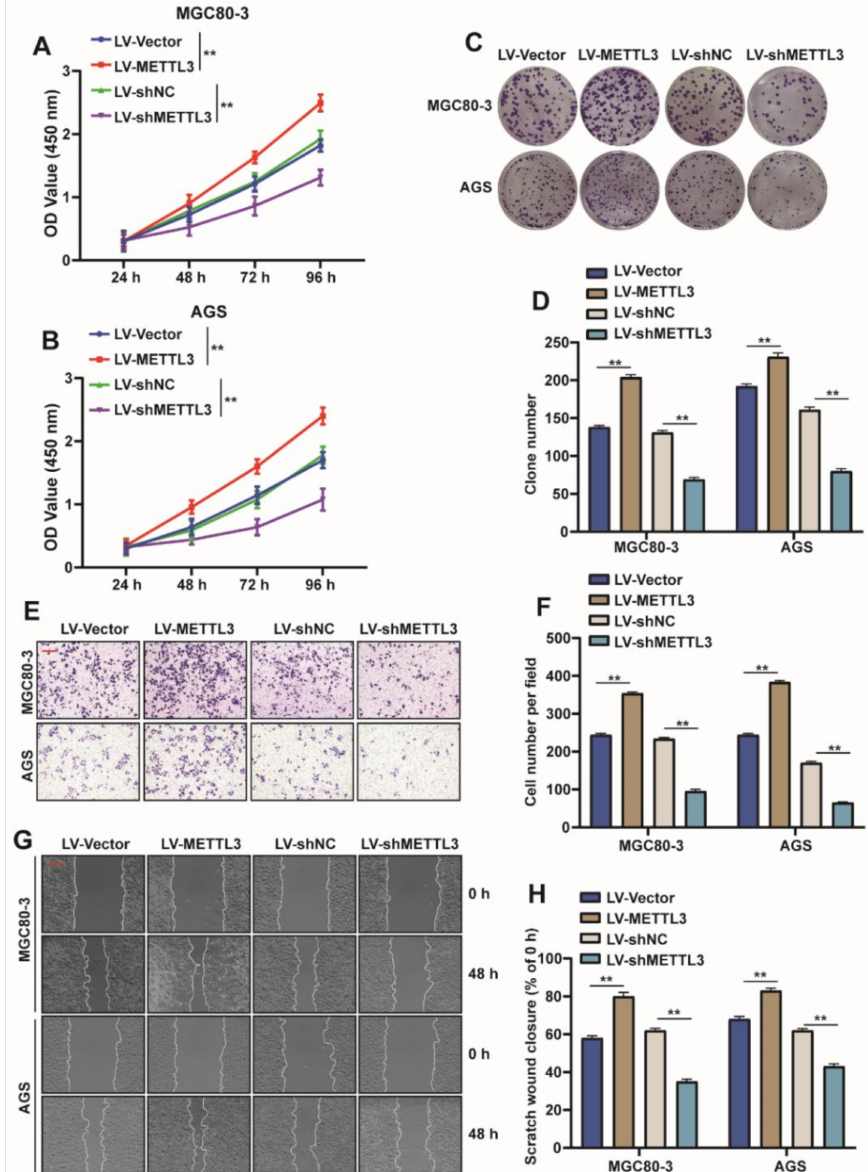
Figure 2. METTL3 promotes the proliferation and migration of GC cells. ( A , B ) Lentivirus-introduced CDS or shMETTL3, CCK-8 of METTL3 was used in MGC80-3 and AGS cells to detect cell viability ( n = 3, **: p < 0.01). ( C , D ) Cell cloning assays to assess the proliferation capacity of MGC80-3 and AGS cells when METTL3 was overexpressed or knocked down, and the number of cell clones was statistically analyzed ( n = 3, **: p < 0.01). ( E , F ) Transwell assays assessed the migratory ability of MGC803 and AGS cells when METTL3 was overexpressed or knocked down, and the number of migrated cells was statistically analyzed ( n = 3, **: p < 0.01). ( G , H ) Wound healing assays to evaluate the migratory ability of MGC803 and AGS cells when METTL3 was overexpressed or knocked down, and statistical analysis of wound healing ability was performed ( n = 3, **: p <